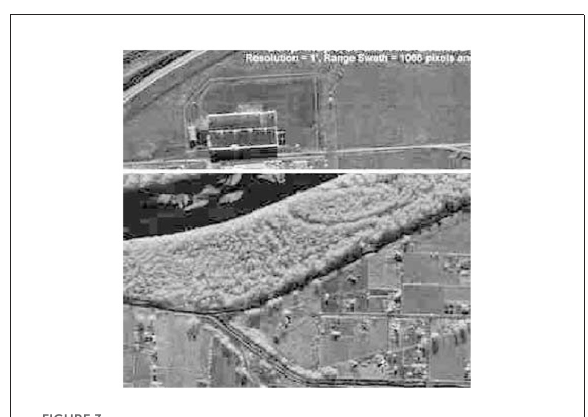
FIGURE3 A SAR image of an agricultural